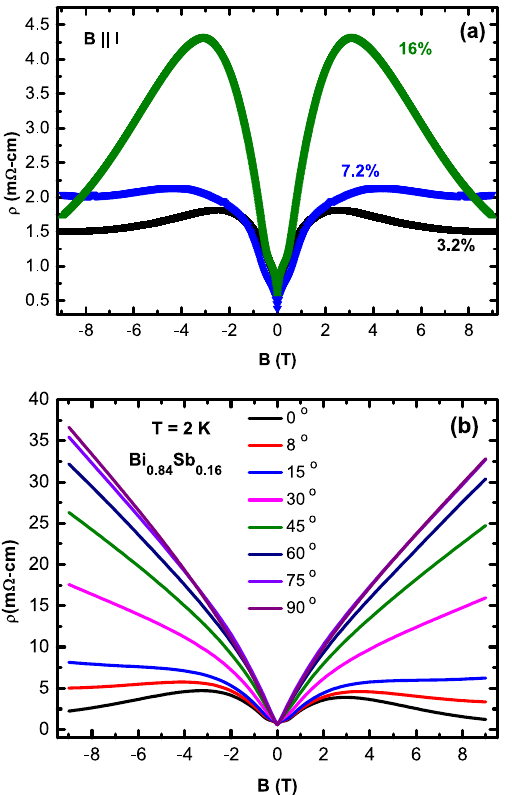
Figure 2. (Color online) ( a ) Resistivity ρ vs magnetic field B at T = 2 K with B || I for Bi 1 − x Sb x ( x = 3.2, 7.2, 16 %). ( b ) ρ vs B at T = 2 K for the x = 16 % sample with B applied at various angles to the